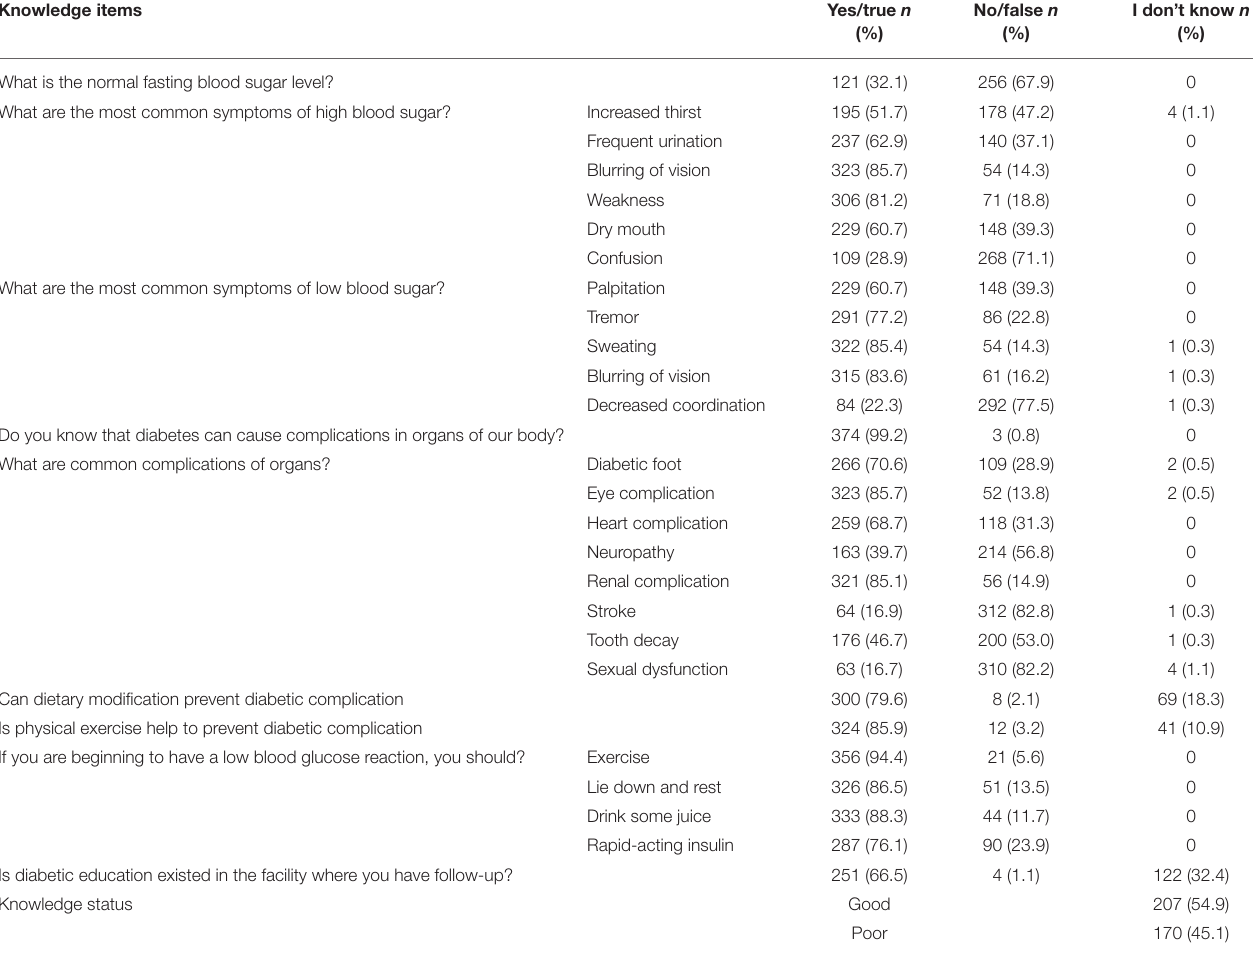
TABLE 3 | The distribution of diabetic patients by their knowledge of diabetic complications in public hospitals; Addis Ababa, Ethiopia, 2020. Knowledge